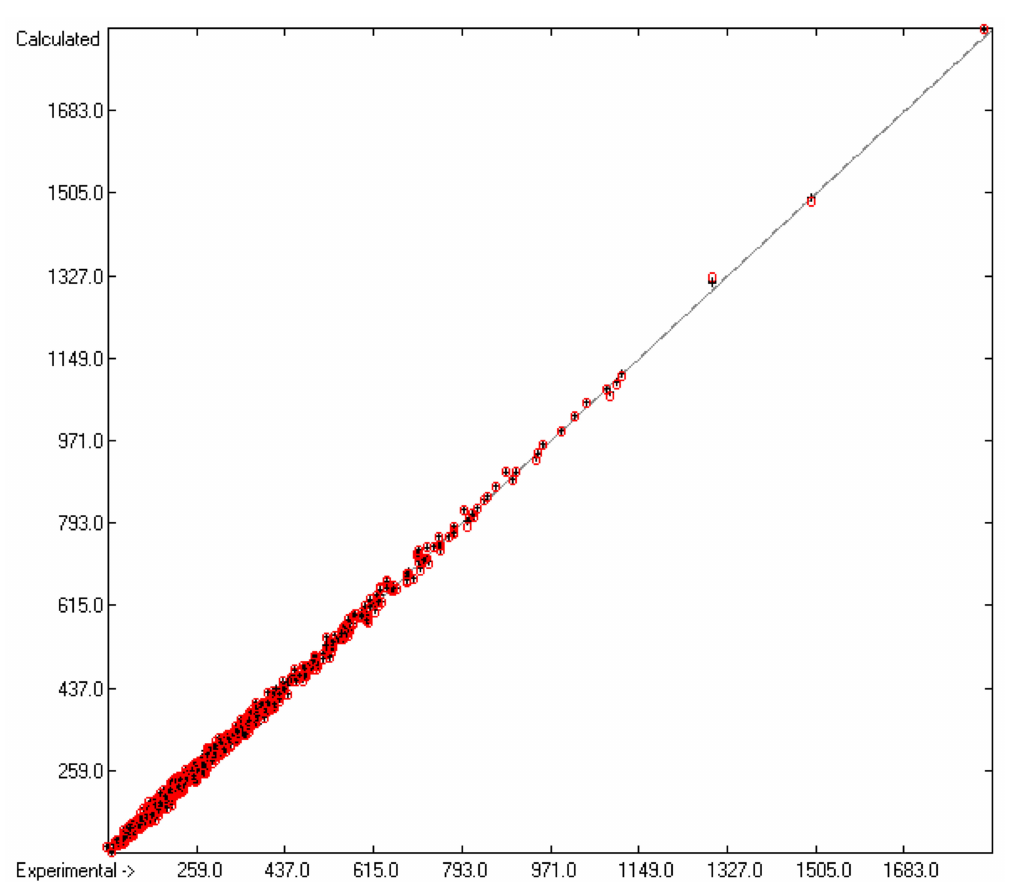
Figure 1. Correlation diagram of the C p (liq,298) data (in J / mol / K). The cross-validation data are superimposed as red circles. ( n = 1111; r 2 = 0.998; q 2 = 0.9975; regression line: intercept = 0.7993; slope =